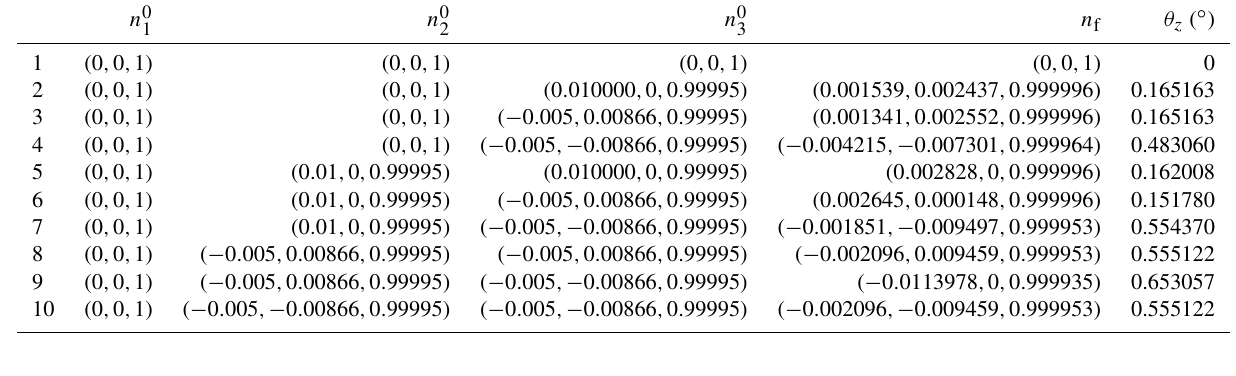
Table 4. Numerical analysis of the direction variation impact.